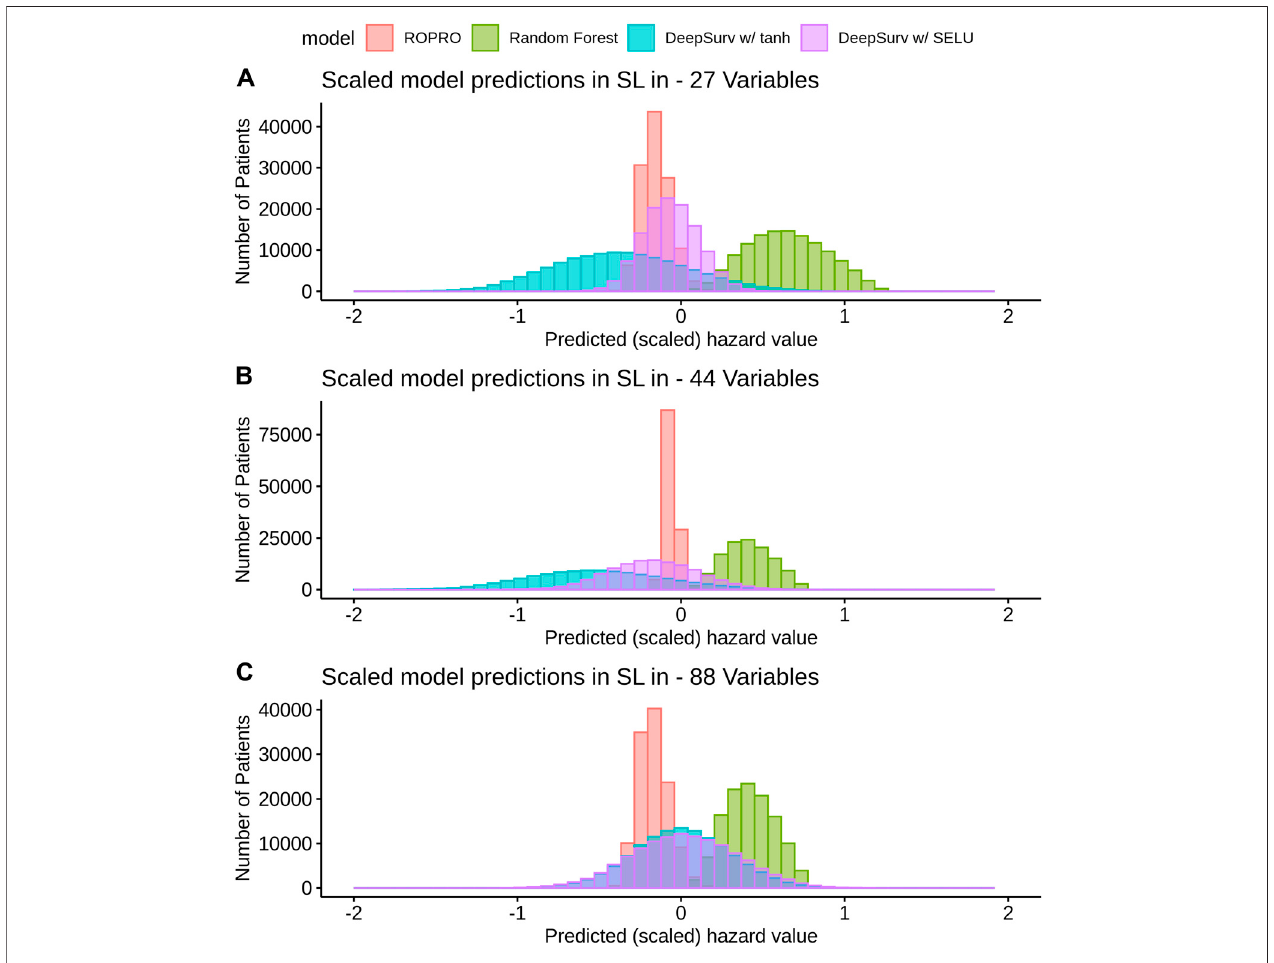
FIGURE4| HistogramoftheriskpredictionsforeachmodelintheSLintheFHtrainingdataset.Theriskvaluescorrespondtotheriskyieldedbytheoriginalmodel, i.e., by ROPRO or DS. The risk was multiplied by the α k value of the model. The α k value scales the risks of each of the models in the SL. In the risk of the SL, only four models are represented, i.e. are not scaled down to zero. Those four models are both DS models, ROPRO and RSF.